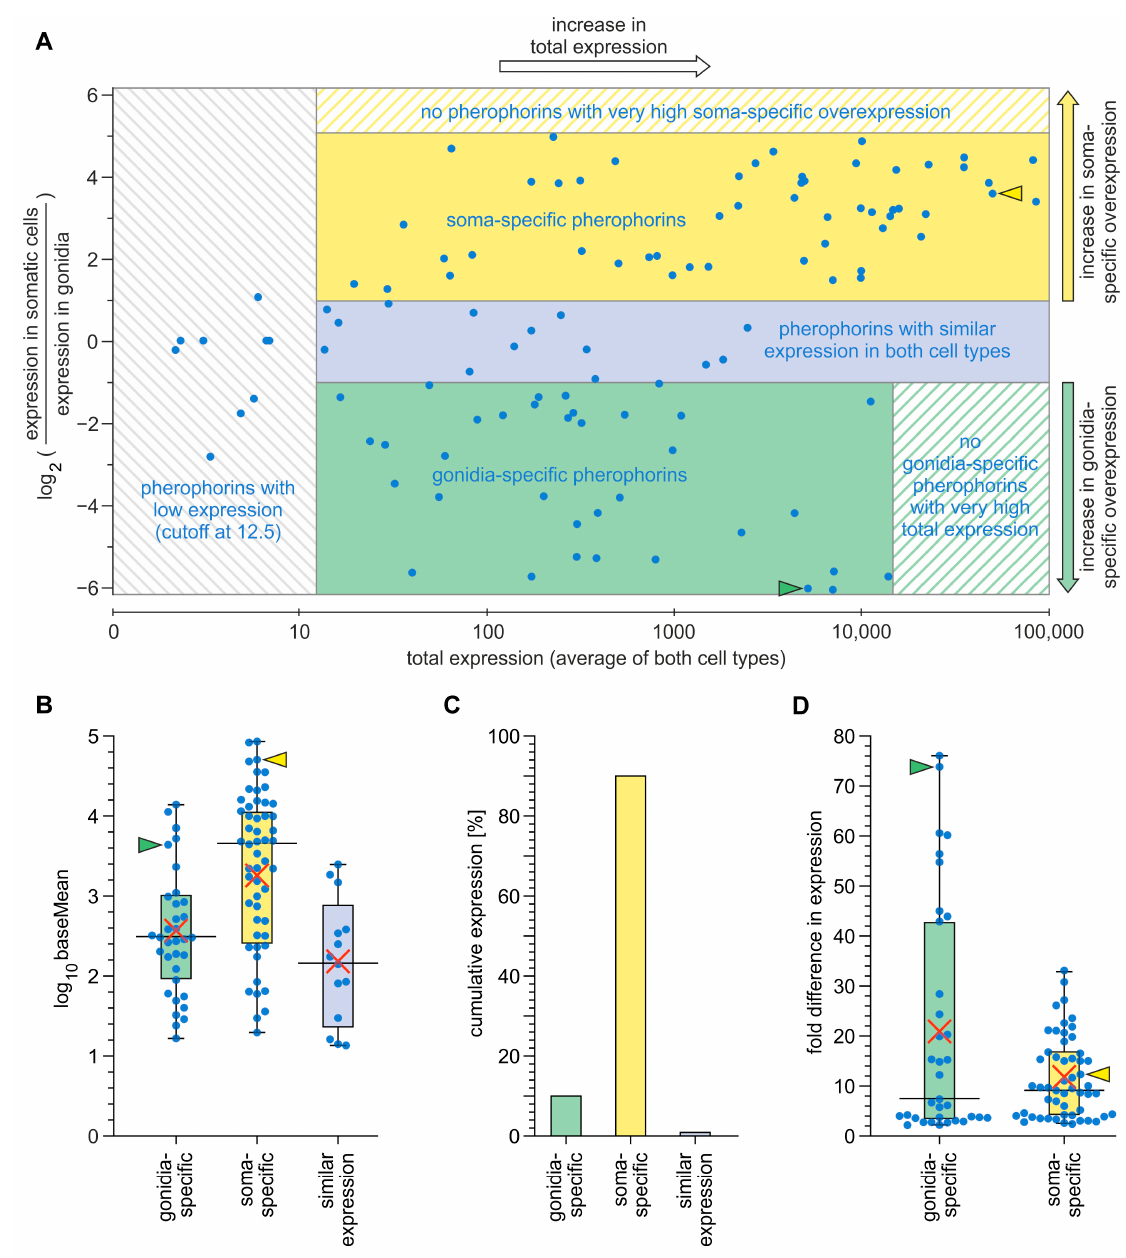
Figure 3. Analysis of V. carteri pherophorin genes concerning cell type-specific expression. The un- derlying data originate from a previous whole transcriptome RNA-Seq analysis [52] . A pherophorin gene is classified as being cell type-specifically expressed if the fold difference in expression between the two cell types is ≥ 2 and the significance value is ≤ 0.05. ( A ) MA-plot (Bland–Altman plot) of expression data of pherophorin genes. Each point in this two-dimensional plot shows the relationship between two sets of data: M-values (log-intensity ratios, Y -axis) represent the log 2 fold difference in expression intensity of a given gene between the two cell types (somatic cells versus gonidia), and A-values (log-intensity averages, X -axis) represent the absolute intensity of expression (mean of normalized counts) of the same gene in logarithmic scale. Fifty-three pherophorin genes (52%) with positive M-values show higher expression in somatic cells compared to the other cell type (yellow background), 35 pherophorin genes (34%) with negative M-values show higher expression in go- nidia compared to the other cell type (green background) and 14 pherophorin genes (14%) show similar expression in both cell types (light blue background). The test for differential expression was based on DEseq calculations [58] and Benjamini–Hochberg multiple testing adjustment [86] . The